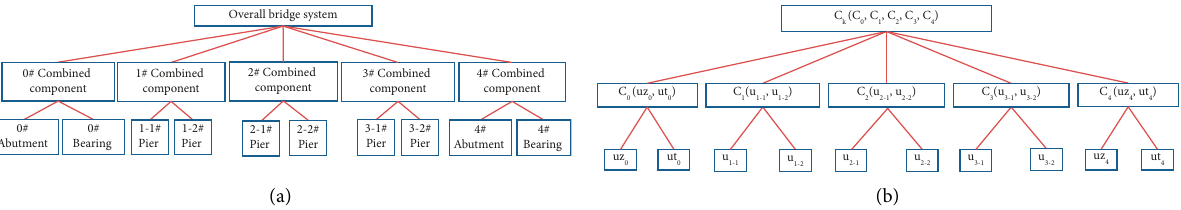
Figure 6: (a) Hierarchical structure of the bridge system and (b) the nested copula model of the bridge